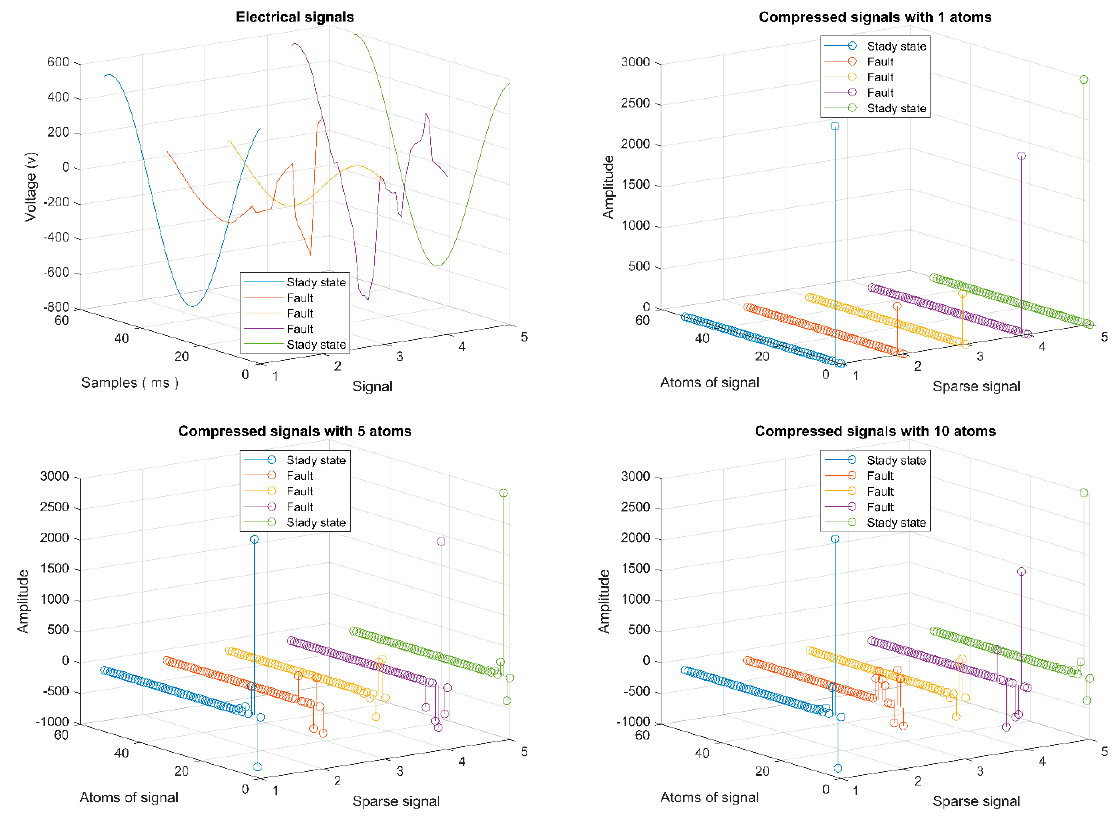
Figure 1. Electrical signal and cycle compression.